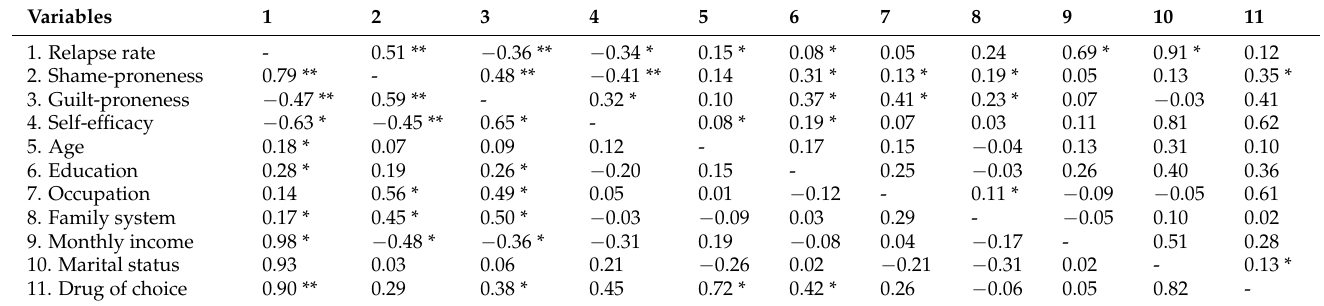
Table 2. Correlation of sociodemographic characteristics with self-evaluative emotions, relapse rate, and self-efficacy among people with PSUD and